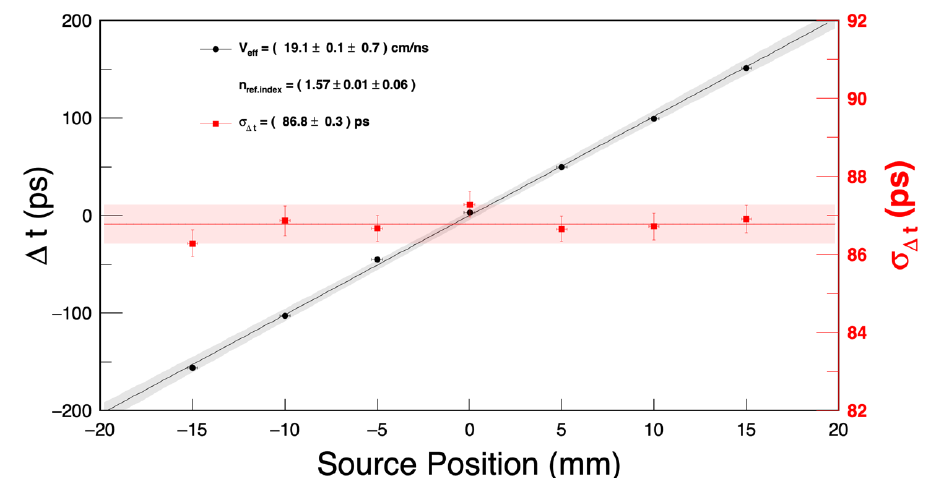
Figure 10. Time difference between left and right SiPMs as a function of source position on the scintillator. The CTR is calculated at a constant fractional threshold of 0.2 (20%). The black and red error bands indicate the 95% confidence level of the